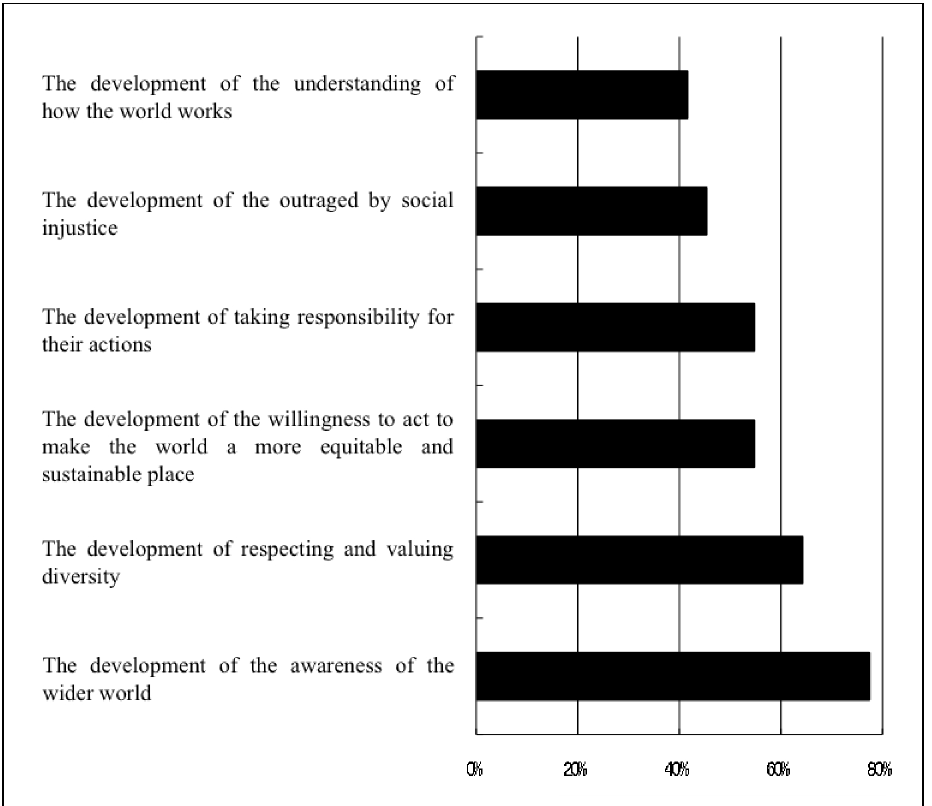
Figure 4:The agreement of the development of conditions of a typical global citizen defined by